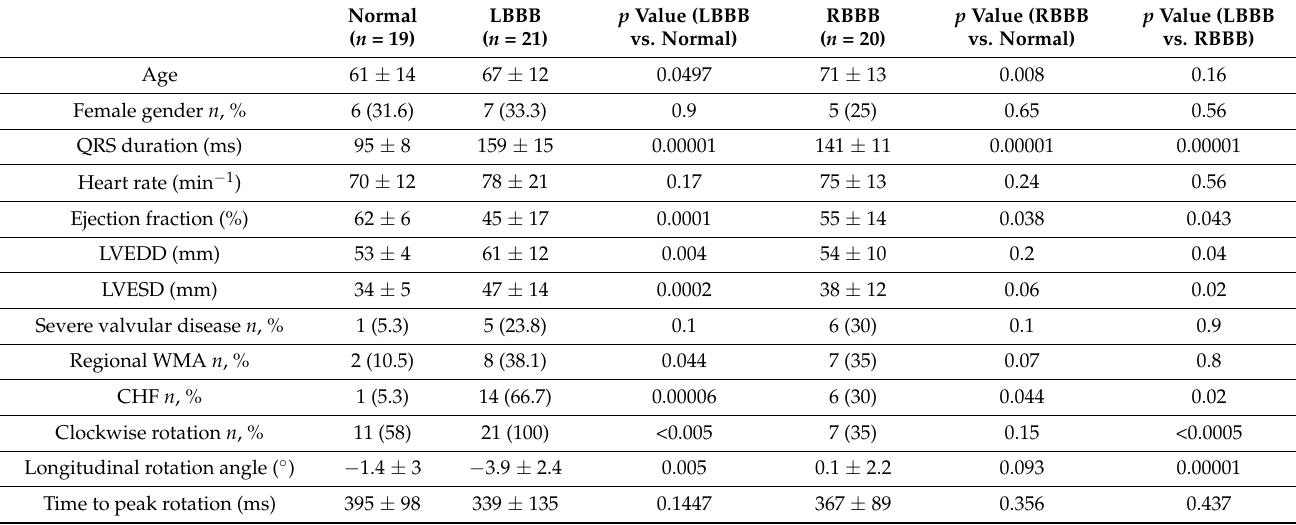
Figure 1. Examples of longitudinal rotation direction and extent in the various patterns analyzed using circumferential rotation algorithm on longitudinal images. Note the “posterior” or annular segment (in pink color) was excluded from analysis. The dotted lines represent the average rotation curve. ( A )—Normal QRS duration, no conduction delay. Note the minimal clockwise rotation. (B)— CLBBB pattern. Definite and extensive longitudinal clockwise rotation. (C)—CRBBB pattern. Defi- nite and extensive longitudinal counterclockwise rotation. This rotation pattern was variable among patients with CRBBB.